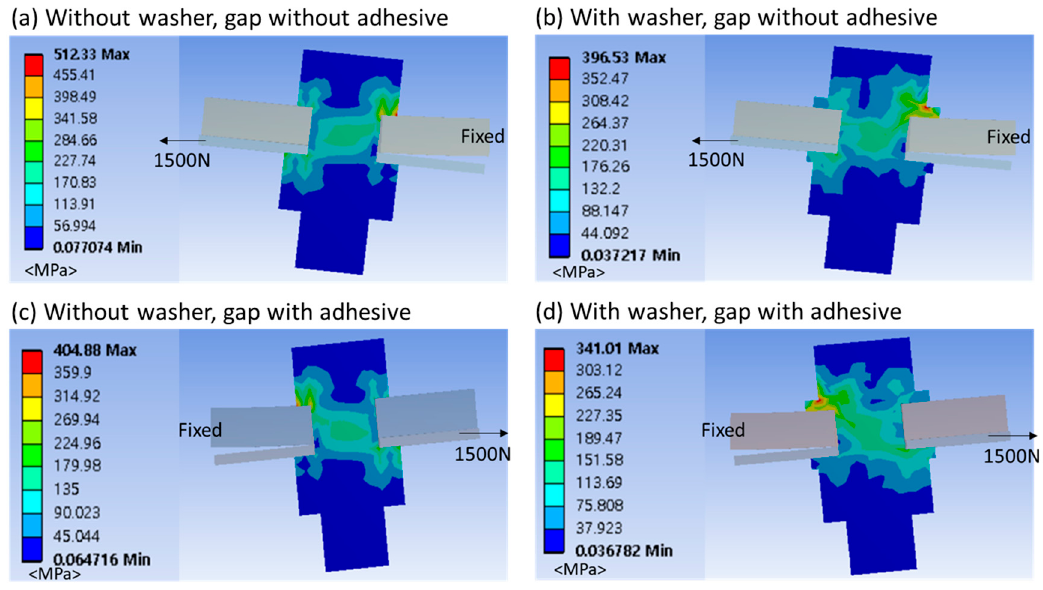
Figure 9. Numerical analysis for bolting cases: ( a ) clearance without an adhesive as well as ( a ) without and ( b ) with the washer; and clearance with an adhesive as well as ( c ) without and ( d ) with the washer.